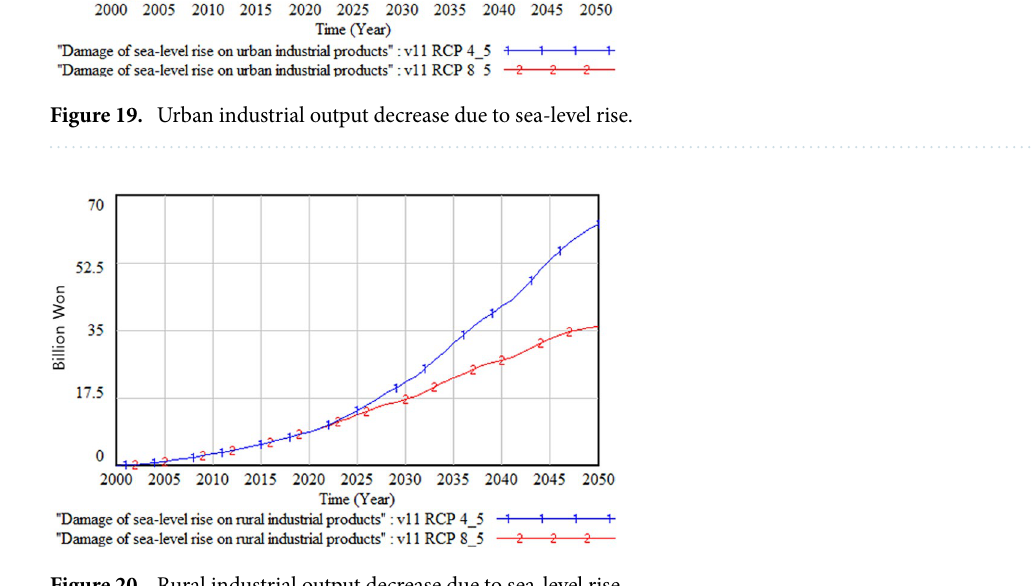
Figure 20. Rural industrial output decrease due to sea-level